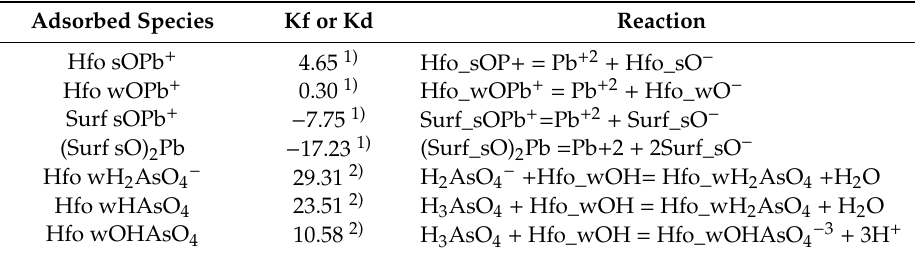
Table 5. Thermodynamic data for the surface complexation constants for Hfo and Surf [27–29].